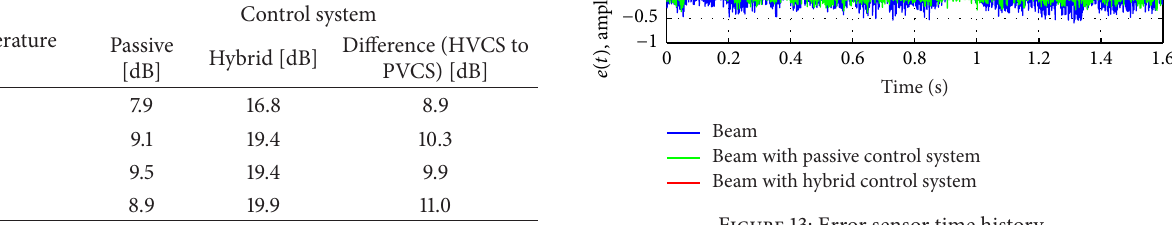
Figure 13: Error sensor time history.